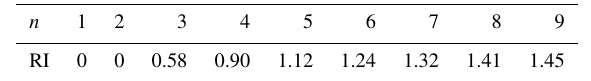
Table 2. RI for various n